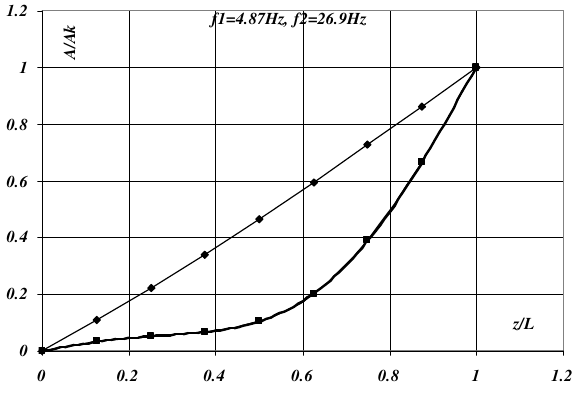
Fig 5. First and second natural frequencies and forms at non-classic